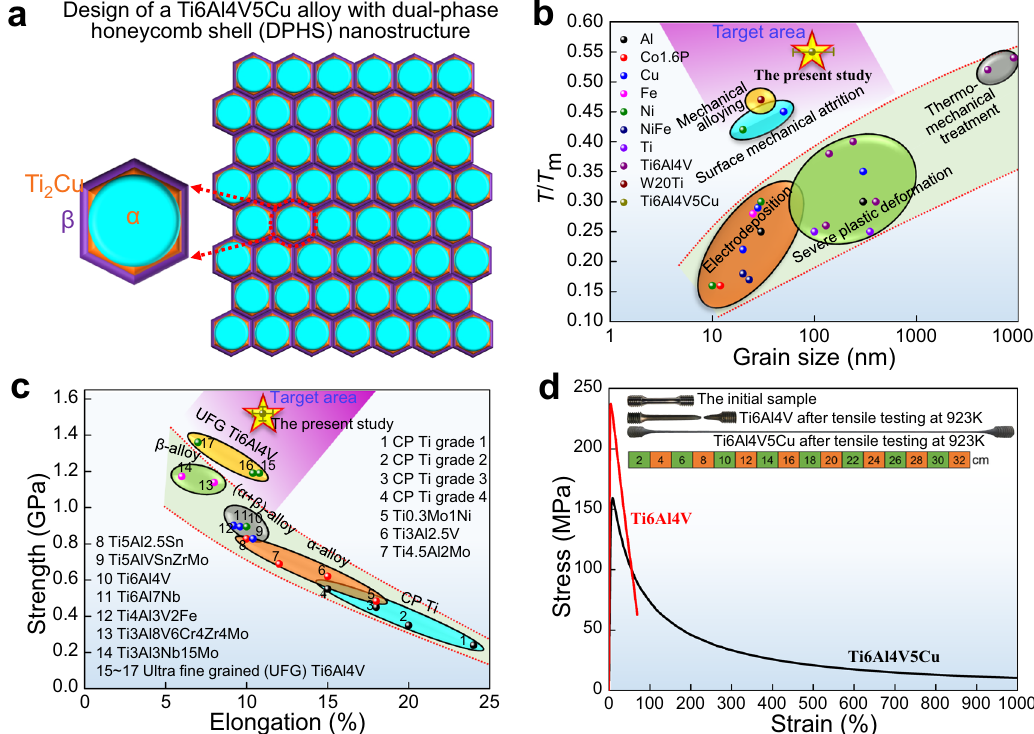
Fig. 1 Design and properties of a nanostructured Ti6Al4V5Cu alloy with high stability. a A dual-phase honeycomb shell (DPHS) nanostructure. b Instability temperature versus average grain size. Literature data for metals processed with electrodeposition 14 , severe plastic deformation 29 – 31 , thermo- mechanical treatment 32,33 , surface mechanical attrition 2,9 , and mechanical alloying 8 . The error bar indicates the standard deviation of the measured grain size. c Tensile strength versus elongation. Literature data for titanium alloys in the ASTM standard and ultra fi ne grained Ti6Al4V alloys 15,16 . Error bars indicate standard deviations of the measured strength and elongation. d Stress versus strain curves at 923 K, showing the superplasticity of the Ti6Al4V5Cu